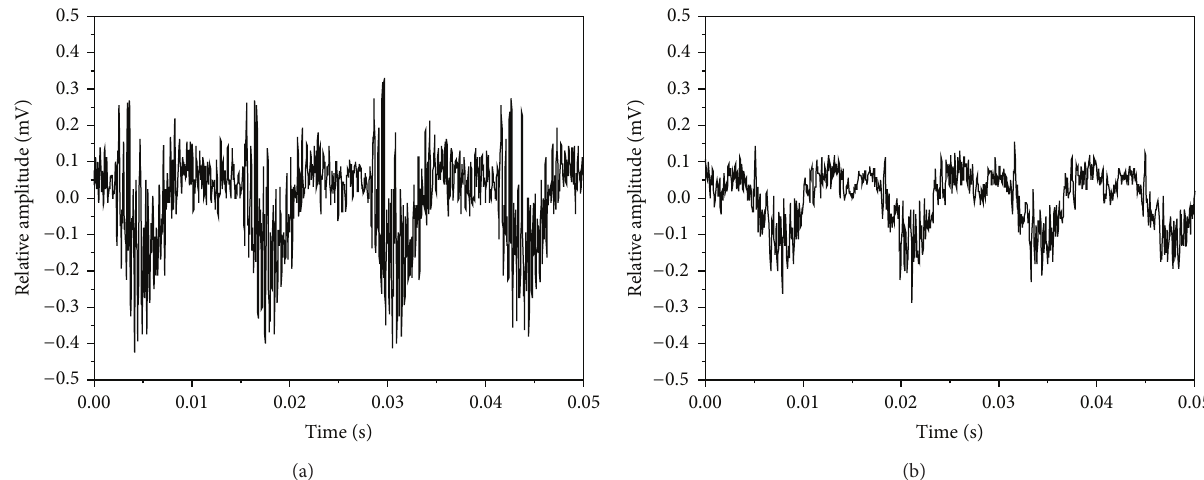
Figure 6: The waveform of the Meta-Lax (a) resonant: 60.9 Hz and (b) subresonant: 59.3 Hz.